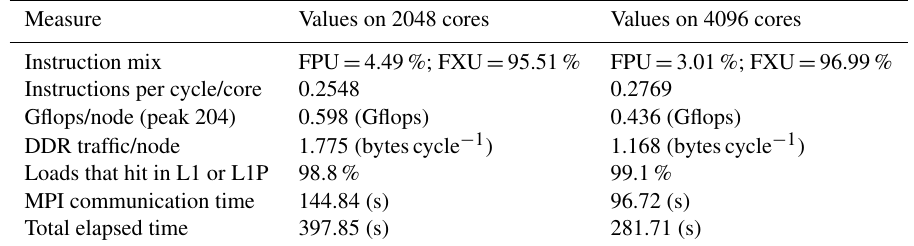
Table 5. Code profiling by applying the HPM (Hardware Performance Monitoring) tool on the BG/Q cluster. The performance values do not include the start-up or the I/O operations. The first column reports the measured parameters, while the other ones show the values on two reference decompositions, respectively, on 2048 and 4096 cores.